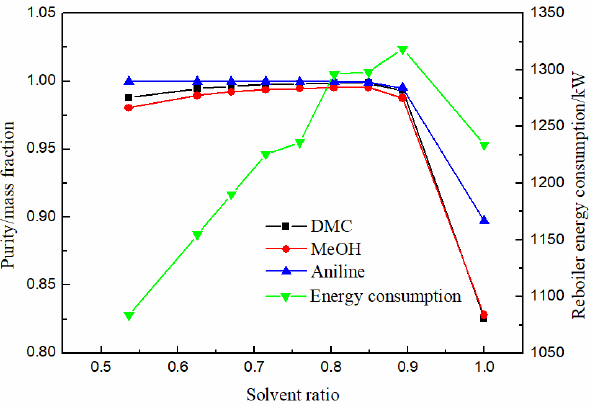
Figure 10. Effect of solvent ratio on product purity and heat duty of reboiler.